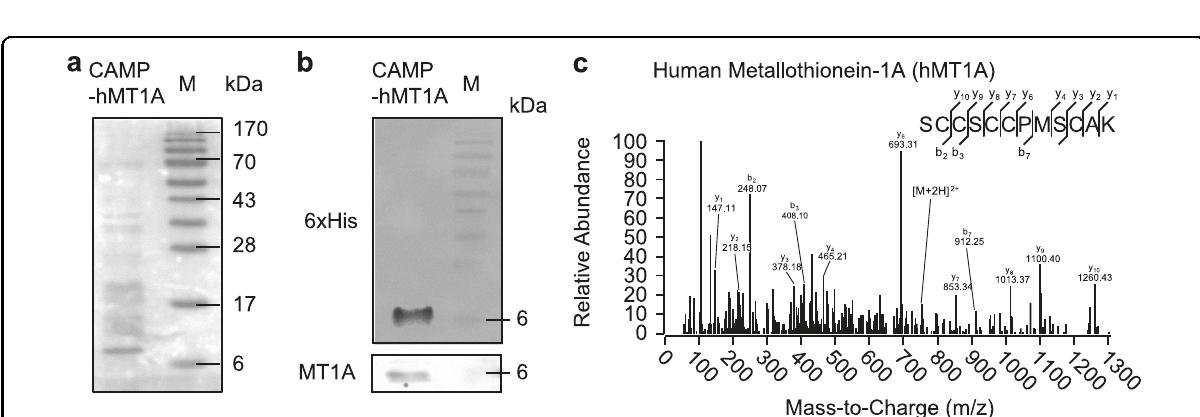
Fig. 2 Mitochondrial localization of CAMP-hMT1A and CAMP-EGFP by transfection. SK-Hep1 cells were stably transfected with pcDNA3.1-myc/ His (mock), CAMP-hMT1A-6xHis, EGFP, or CAMP-EGFP. a Confocal microscopy images showing the localization of CAMP fusion proteins. Cells were stained with MitoTracker (MitoT, red) and immunostained with anti-6xHis or EGFP antibodies (green) before microscopy (×400, scale bar = 10 μ m). Co-localization of red and green signal appears yellow in merged images. b Western blot analysis. Cell or mitochondrial lysates were analyzed by western blot with 6xHis-tag to detect CAMP-hMT1A and β -actin and HSP60 antibodies for loading and mitochondria controls, respectively